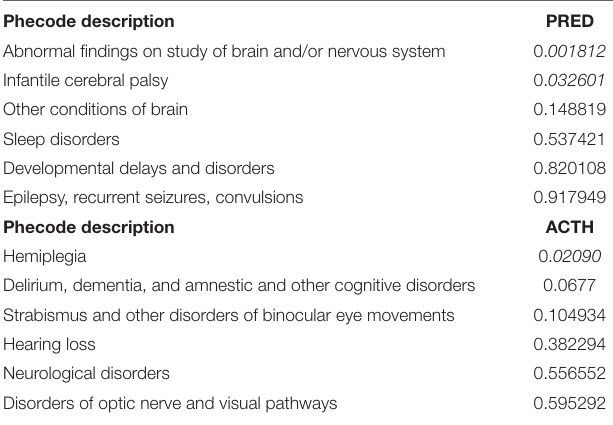
TABLE 2 | Unadjusted p- values of neurological phecodes, in prednisolone/prednisone (PRED) and adrenocorticotropic hormone (ACTH)